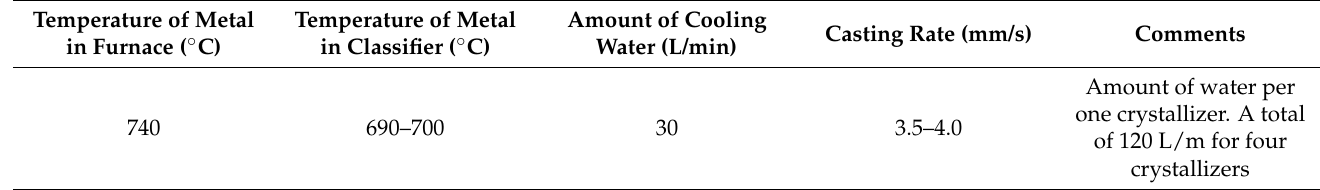
Table 1. Casting process